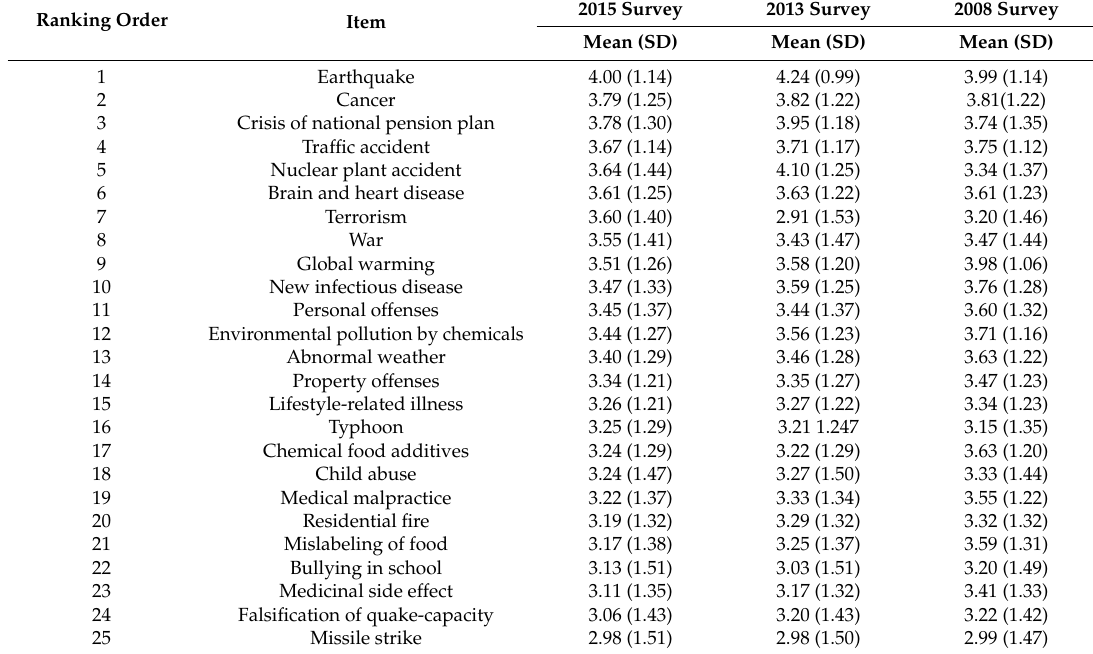
Table 1. Average anxiety ratings for each hazard measured in the surveys in 2008, 2012, and 2015. Ranking